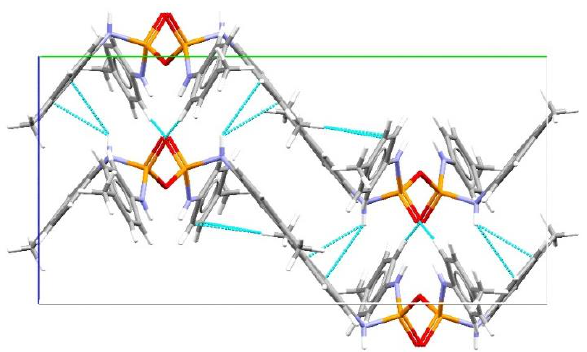
Figure 9. Intermolecular and intramolecular non-hydrogen bonding interactions in the structure of O((4-MePhNH) 2 PO) 2 (generated in Mercury [25]). O((4-MePhNH) 2 PO) 2 (generated in Mercury